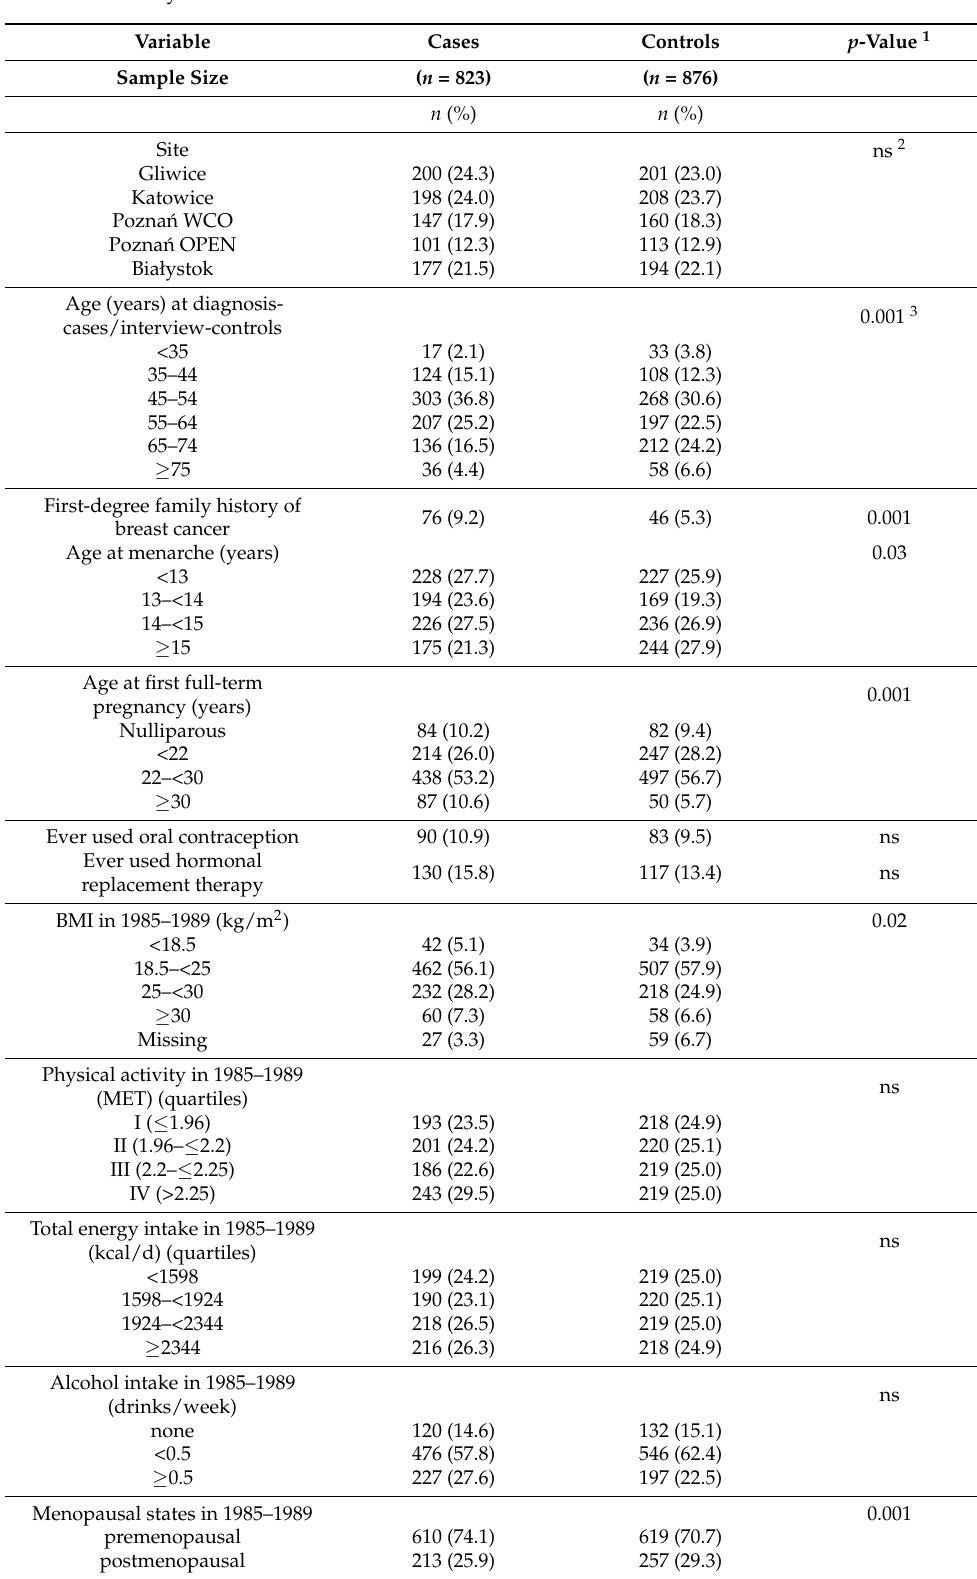
Table 1. Selected characteristics of breast cancer cases and controls residing in Gliwice, Katowice, Pozna´n and